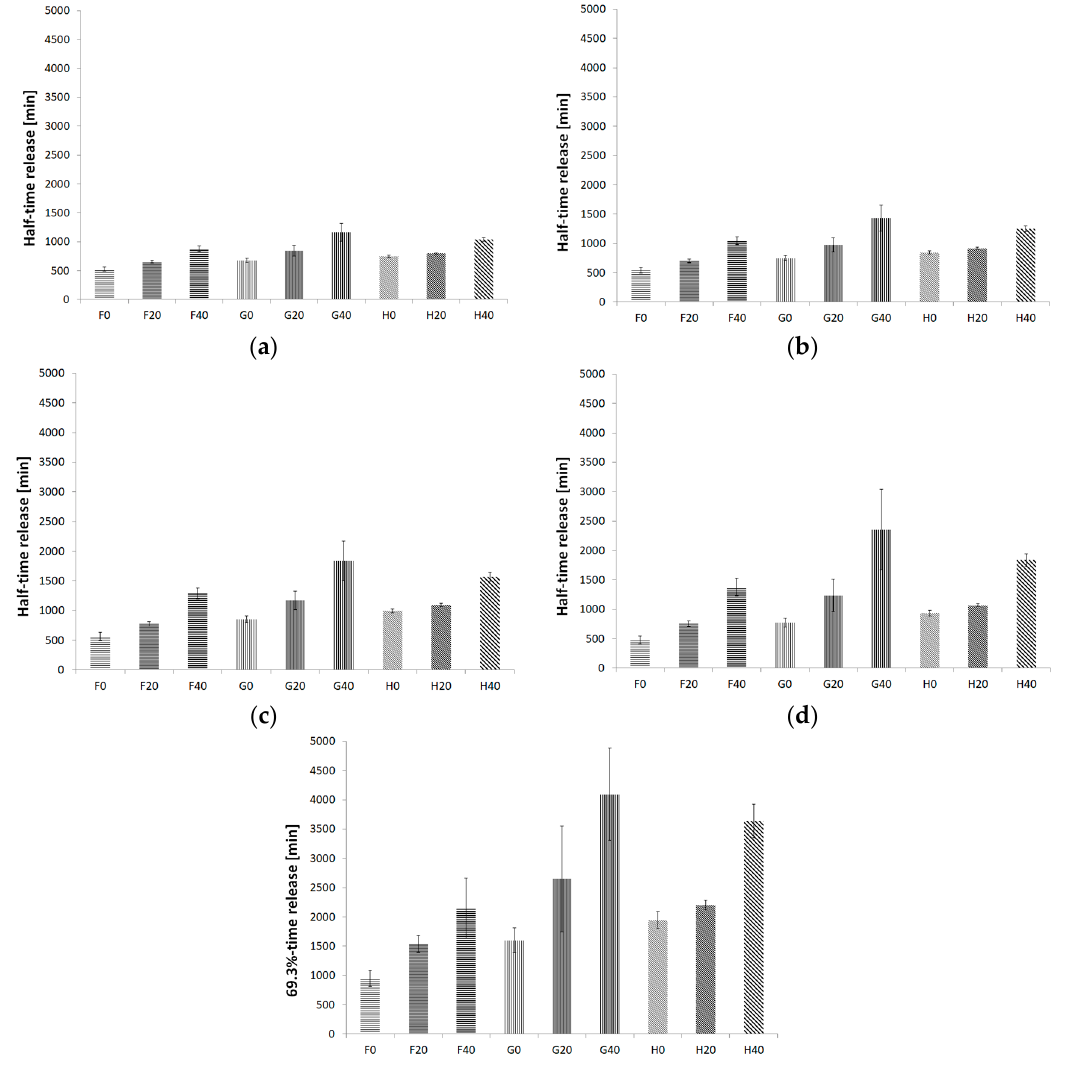
Figure 8. Half-time release and 69.3%-time release histograms of β E for the formulations with hydrogels of MC (F0, F20, F40), PA1 (G0, G20, G40) and PC-11 (H0, H20, H40), evaluated according to the kinetics models: ( a ) zero-order kinetic equation, ( b ) first-order kinetic equation, ( c ) second-order kinetic equation, ( d ) Higuchi model, ( e ) Weibull model; the error bars represent SD, n = 6.